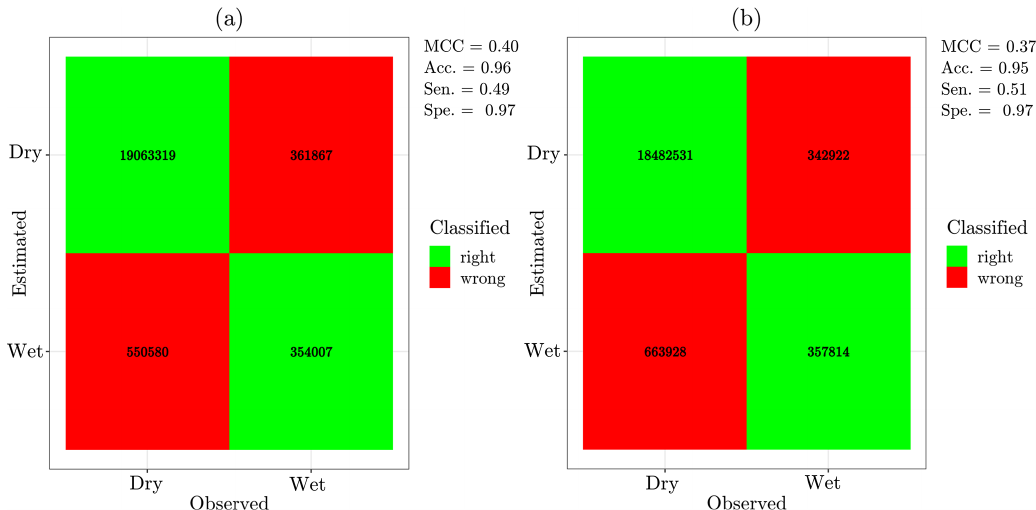
Figure 4. Confusion matrices and binary classification metrics for the wet–dry classification process: (a) results of the wet–dry classification using calibrated parameters and (b) results of the wet–dry classification using default parameters. Note: Matthews correlation coefficient (MCC), accuracy (Acc.), sensitivity (Sen.), and specificity (Spe.)